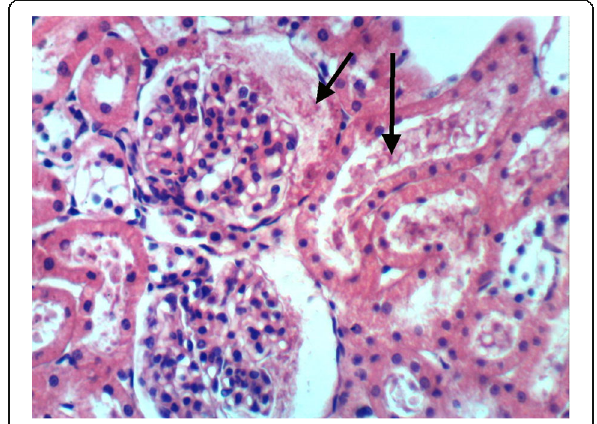
Fig. 12 Photomicrograph of rat ’ s kidney fed the balanced diet supplemented with vanillin+oral pot.bromate, showing congestion of renal blood vessel (H&E ×